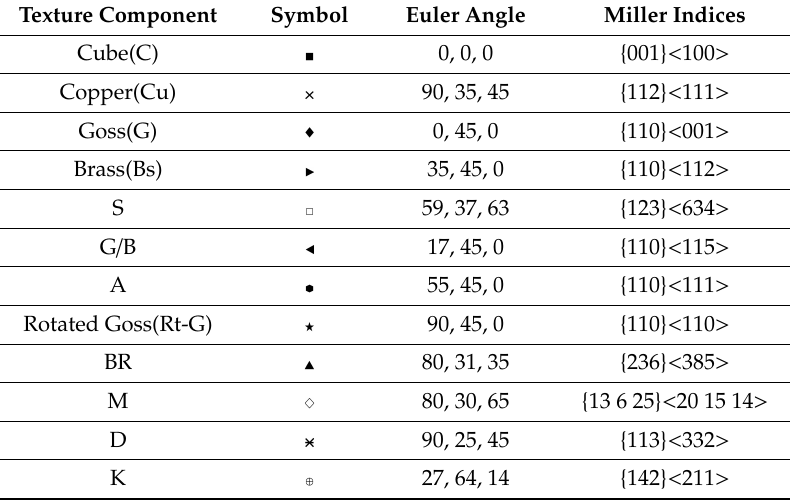
Table 1. Important recrystallization texture components in the CoCrNi